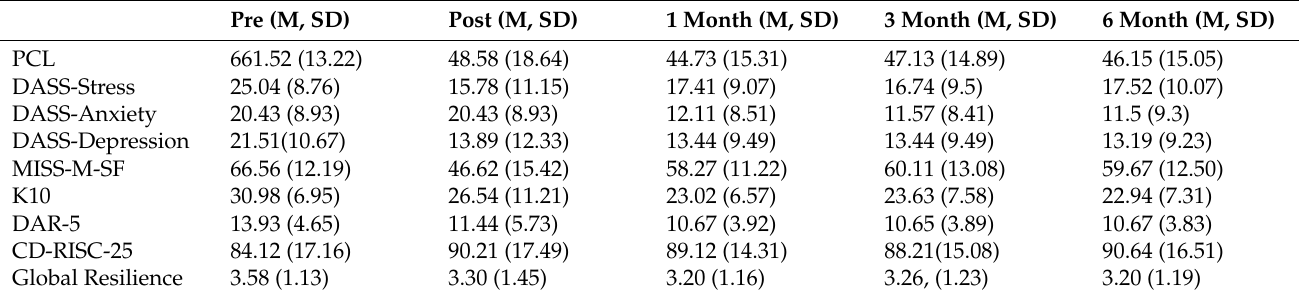
Table 2. Descriptive survey